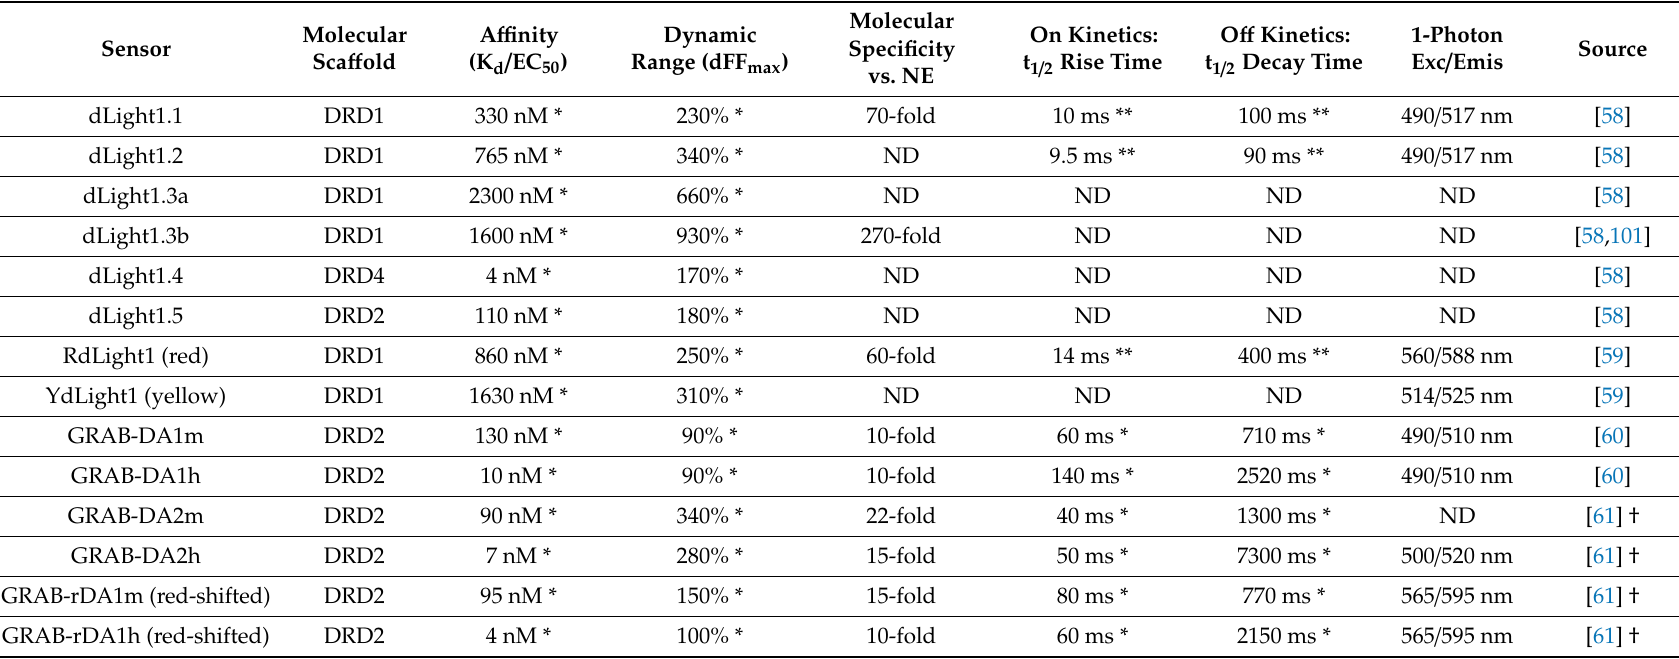
Table 1. The G protein coupled receptors (GPCR) dopamine biosensor toolbox and intrinsic